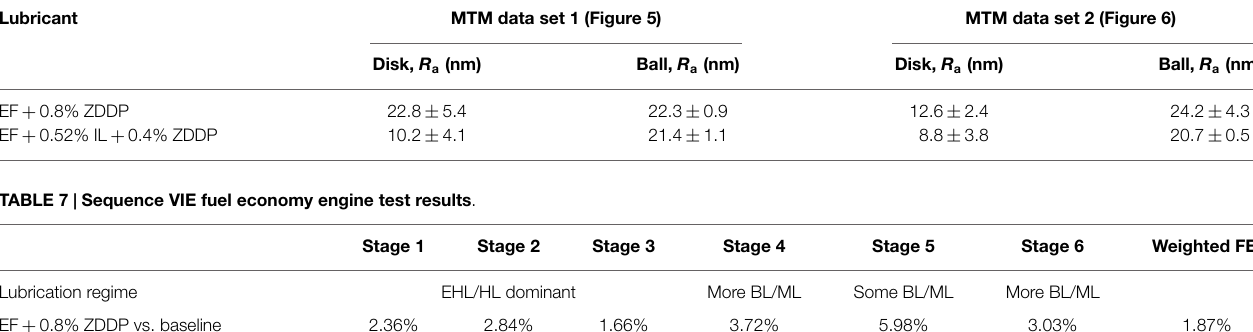
TABLE 6 | Measured arithmetic average surface roughness of balls and disks of MTM tests . Lubricant